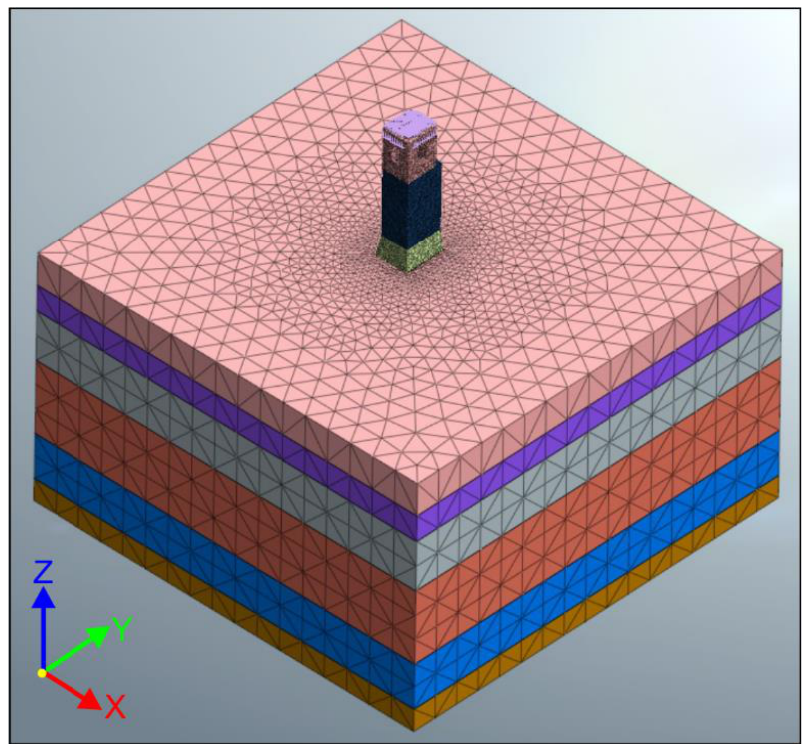
Figure 14. FE model of the soil as uniform-depth horizontal layers.